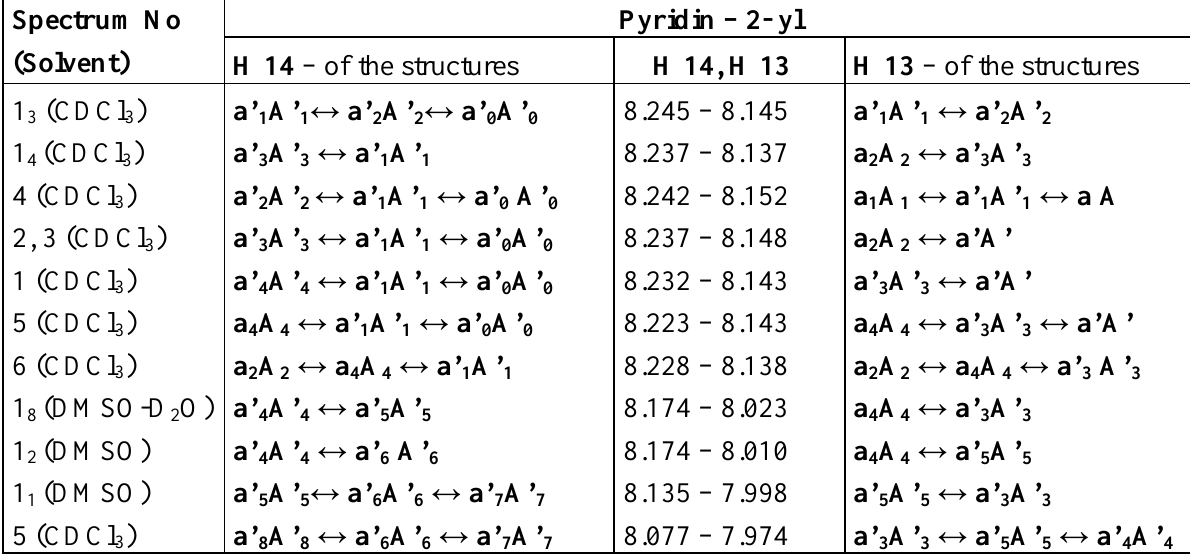
Table 4 . The 1 H-NMR chemical shifts δ [ppm] from TMS of 1